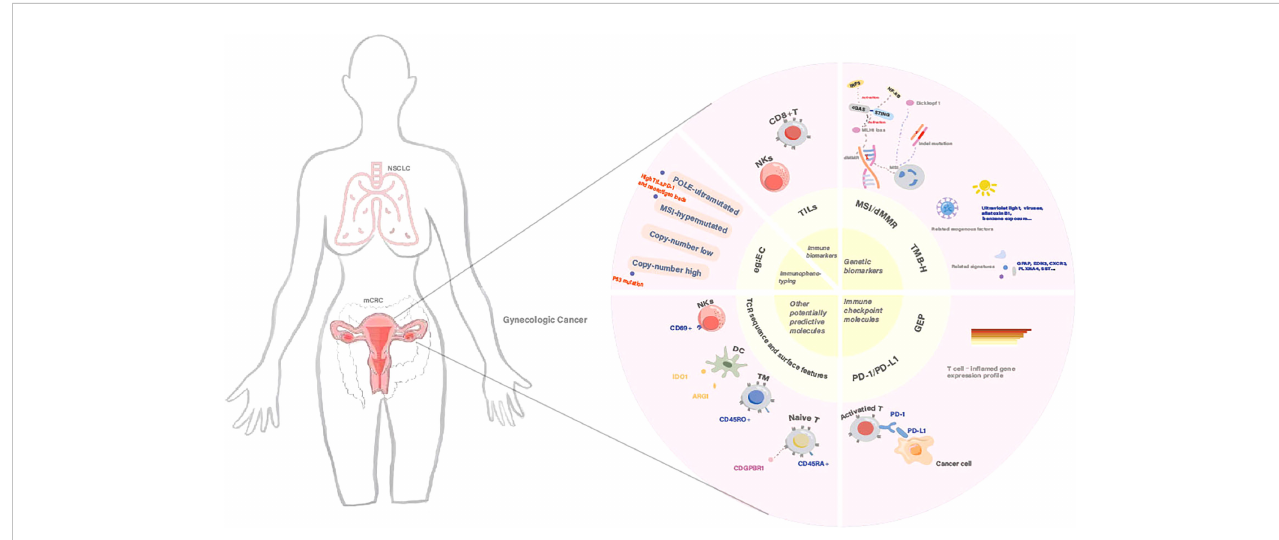
FIGURE 1 The status quo and ef fi cacy prediction of immunotherapy in gynecologic